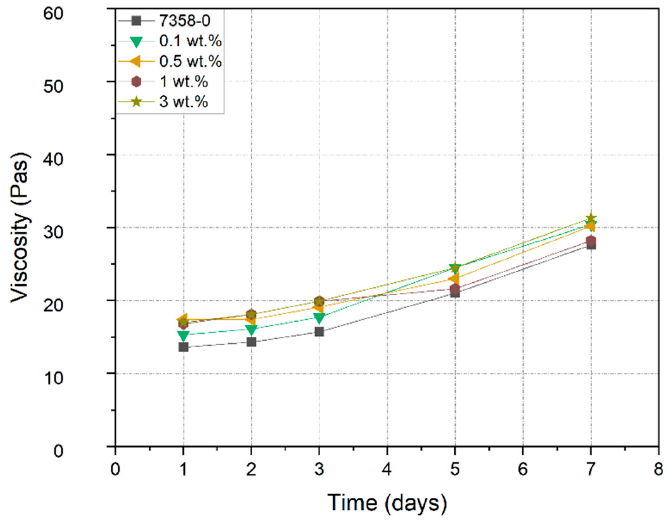
Figure 6. Influence of palygorskite-1.0MPTMS addition on Si-PSA composition viscosity.